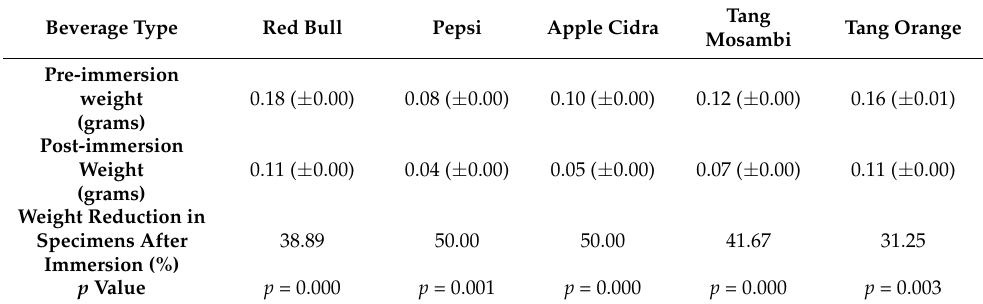
Table 7. Weight of specimens before and after immersion in highly acidic beverages (mean and SD).